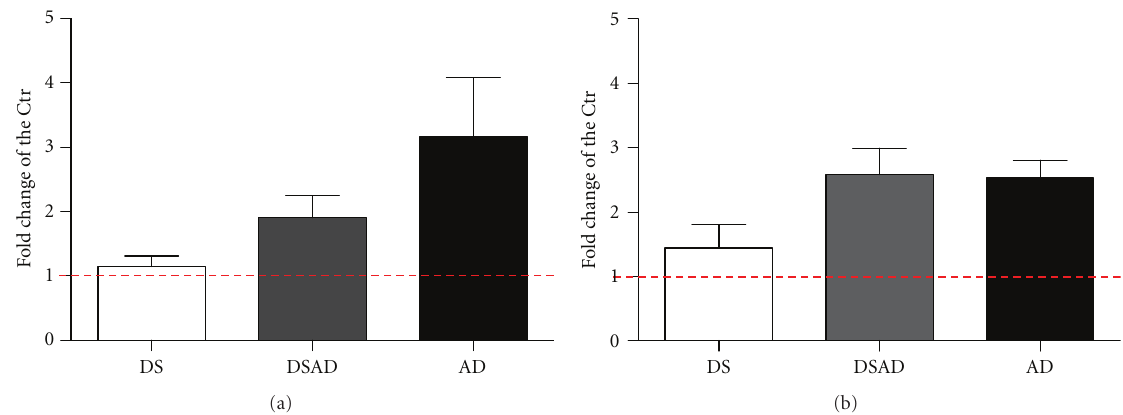
Figure 1: Accumulation of mitochondrial DNA mutations in DS, DSAD, and AD frontal cortex (a) and lymphoblastoid cell lines (LCL) (b). The graph was plotted as fold di ff erence with respect to age-matched controls. DS brains age group: 0–40, DSAD age group: 45–68, and AD age group: 65–90. For each group 6 to 16 samples were analyzed. LCL lines for all groups (DS, DSAD, DAD, and control) were obtained from 40–60 years old donors, 6–8 samples per group. The red line shows the baseline mutation level for the control group.